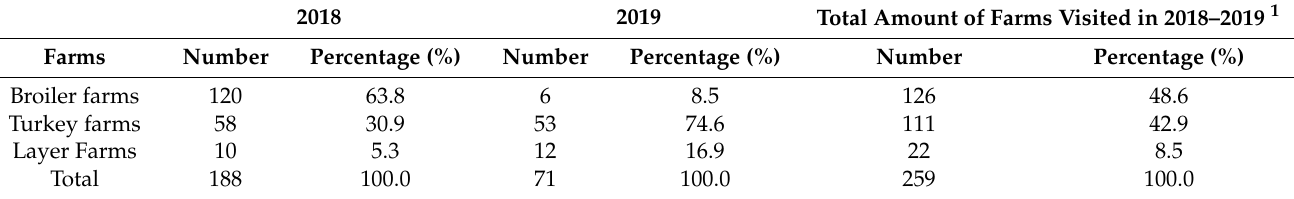
Table 1. Poultry farms investigated in 2018 and 2019 for biosecurity compliance. Farms are grouped according to the year of visit (2018 and 2019). The total number of farms visited in the two-year period is also reported.